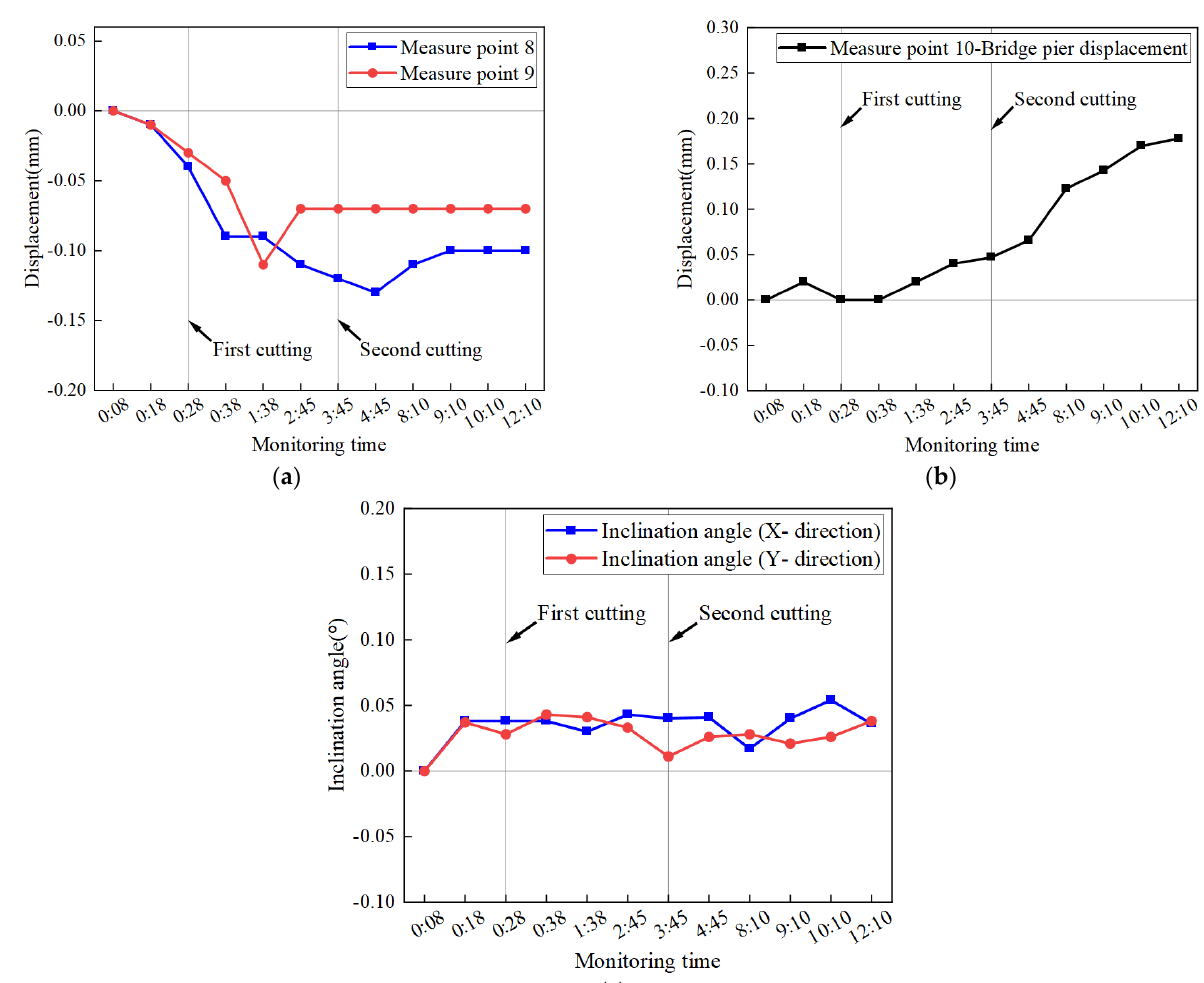
Figure 13. Displacement monitored during pile cutting stage: ( a ) displacement of underpinning beam; ( b ) displacement of bridge pier; and ( c ) pier inclination. beam; ( b ) displacement of bridge pier; and ( c ) pier